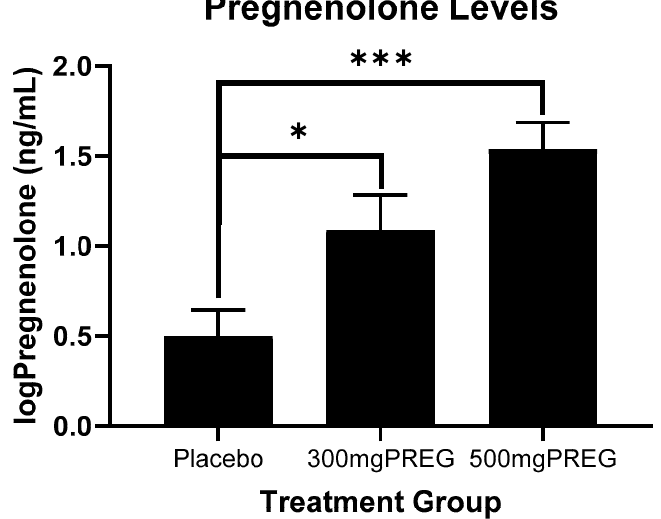
Figure 2. Log-transformed circulating pregnenolone levels as a function of placebo vs. PREG treatment groups, combined across timepoints and conditions. Pregnenolone levels were significantly higher in the 300 mg PREG group ( p = 0.02) and the 500 mg PREG group ( p = 0.0002) compared to placebo. All data are displayed as mean ± S.E.M. * p < 0.05; *** p < 0.001